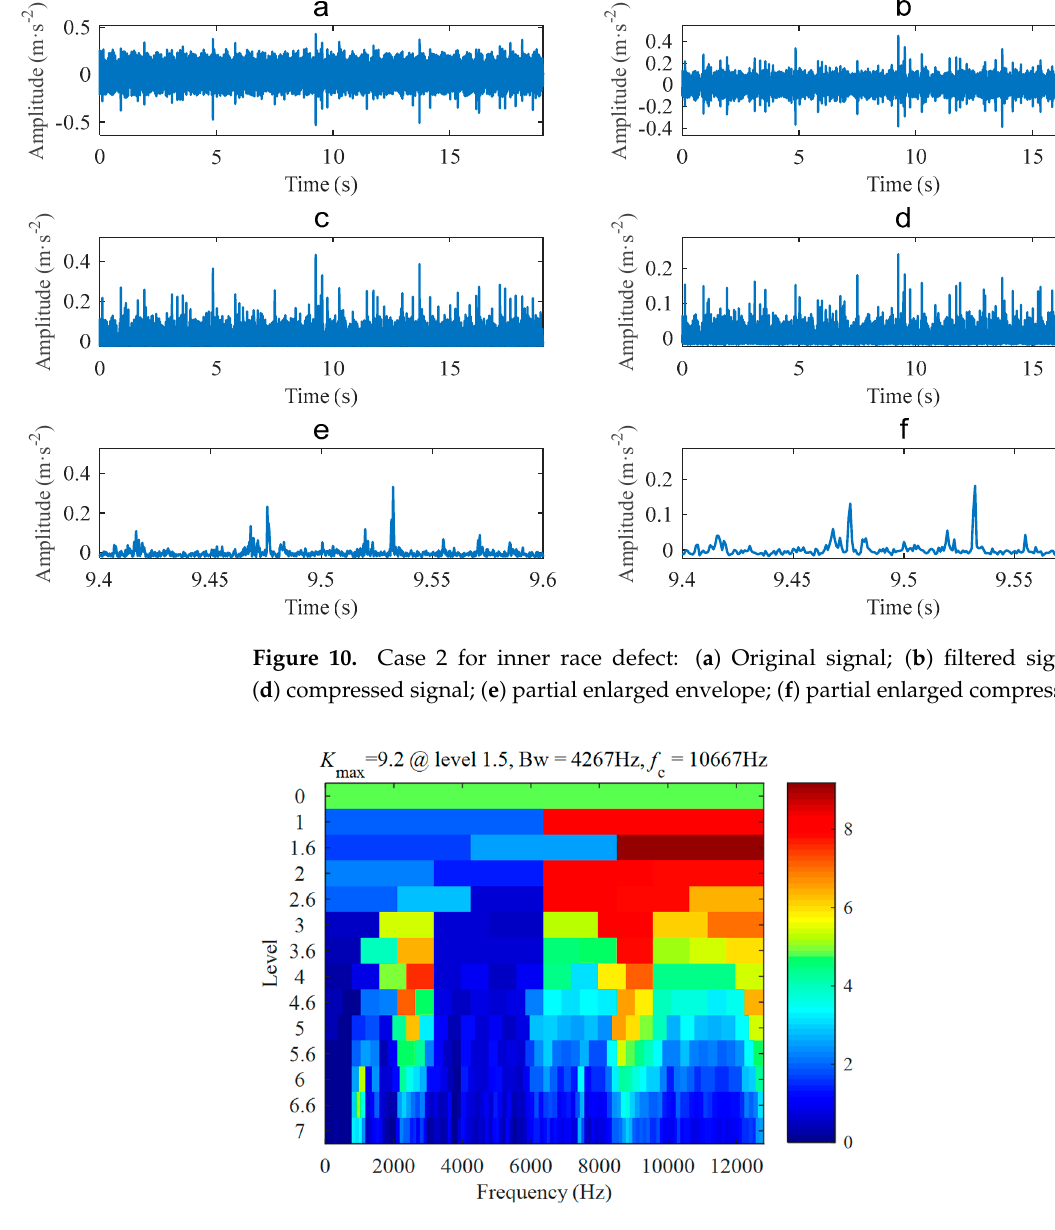
Figure 11. Case 2 for inner race defect: Kurtogram results of the vibration signal.